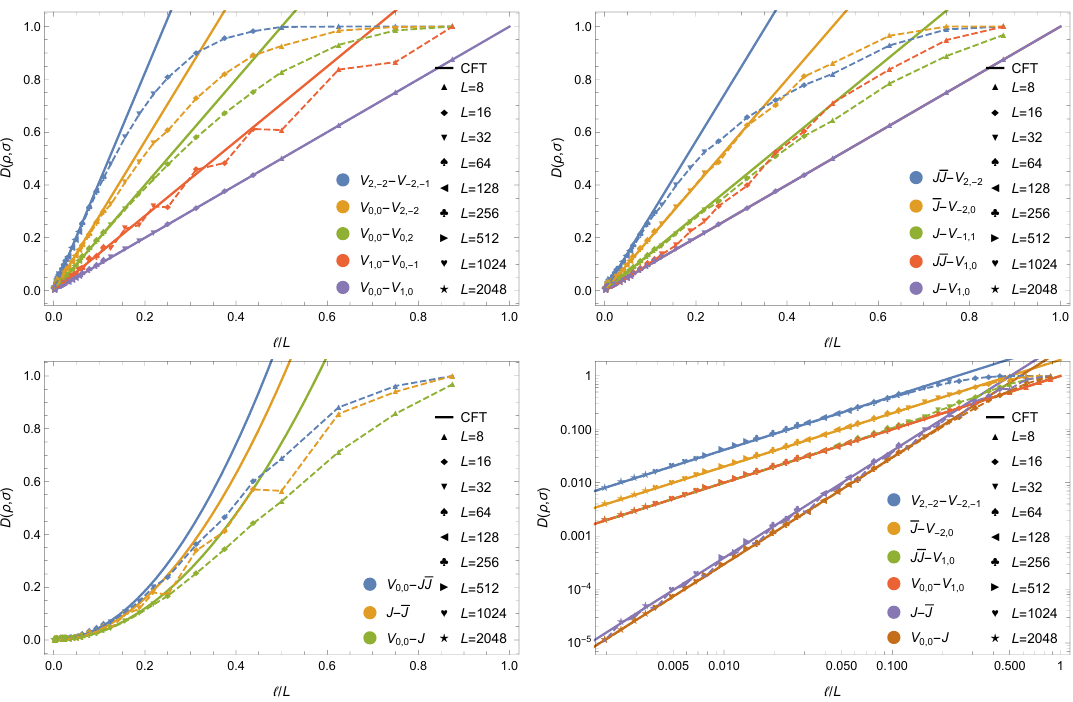
Figure 2 . Trace distance D ( (cid:26); (cid:27) ) between the RDMs in several low-lying states as a function of the ratio between the subsystem ‘ and the system size L in the XX spin chain. The solid lines denote the leading order CFT prediction in the limit of short interval, eqs. (4.19), (4.20) and (4.21). The symbols joined by dashed lines represent numerical data, obtained with the method in appendix A. Di(cid:11)erent symbols correspond to di(cid:11)erent L and di(cid:11)erent colours correspond